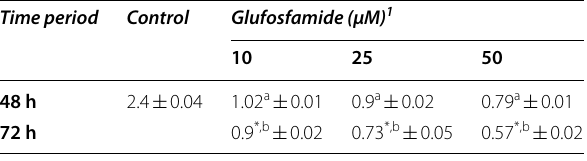
Table 6 Effects of glufosfamide on Bcl2 gene expression in HepG2 cells